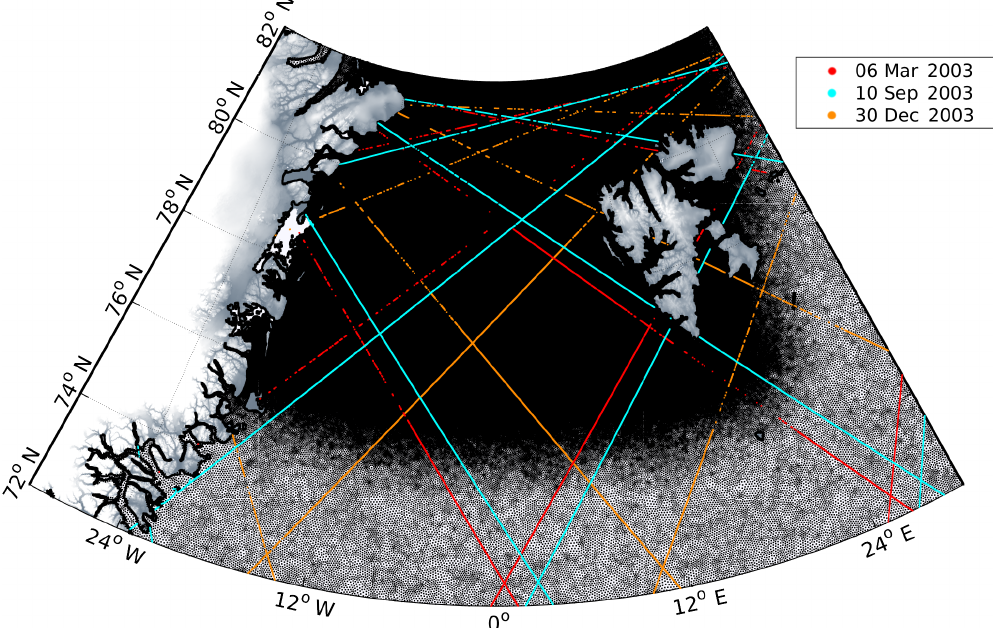
Figure 2. Locations of selected altimetry observations in wintertime and summertime. The small black dots indicate the unstructured FESOM grid nodes migrating at higher latitudes to a apparently closed black background.